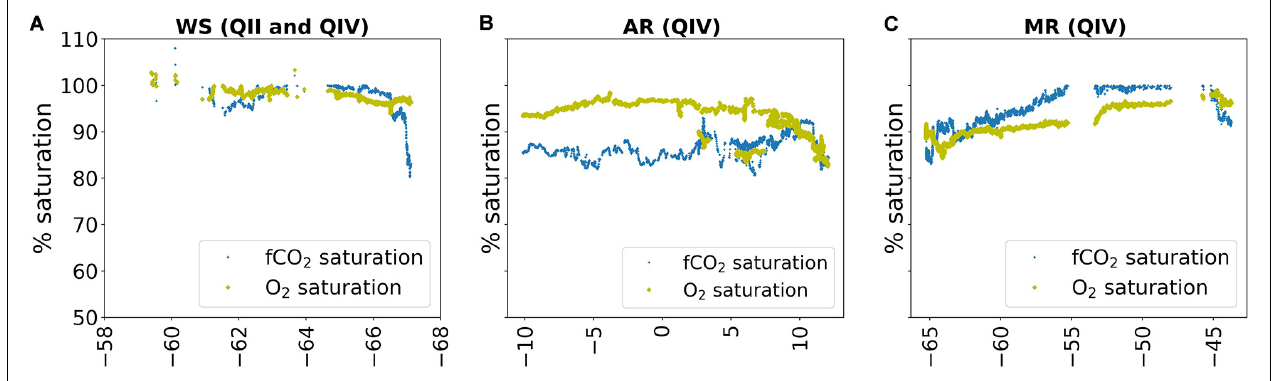
FIGURE 8 | Spatial distribution of the fCO 2 sat/O 2 sat correlations for the case waters in QII and QIV. (A) WS region, (B) AR region, and (C) MR region.